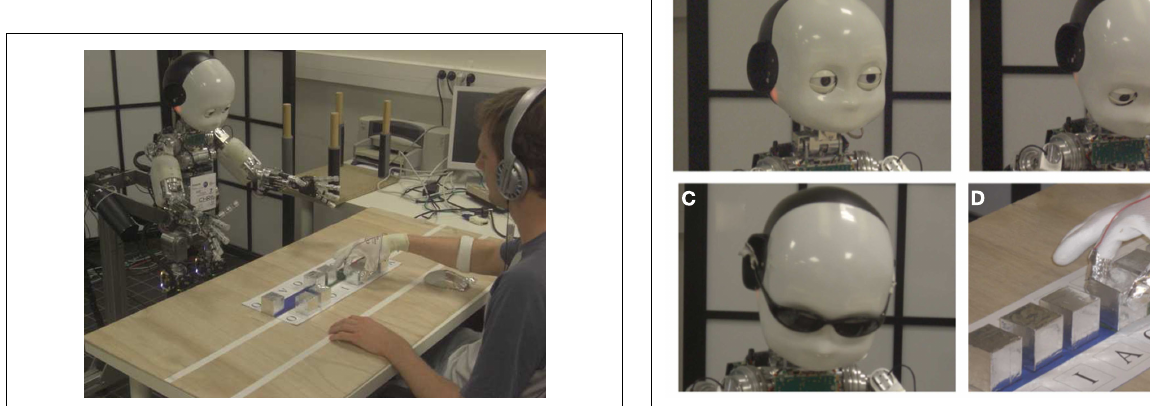
FIGURE 7 | Human–Robot interaction conditions (A–C) and the contact detection glove (D). In the head fixed condition (A) , the robot stays in a neutral position, moving neither the eyes nor head. In the full gaze condition (B) , the robot searches for the correct cube with coordinated gaze (eye and head movement).The sun glasses condition (C) , is the same as (B) except the robot wears sun glasses. In this condition, the human cannot see the eyes. (D) Illustrates the contact detection glove. Contact is detected when the electrical circuits are closed.There two kinds of contact detections: (i) when the glove touches/releases a cube and (ii) when the glove palm contacts/moves from the initial